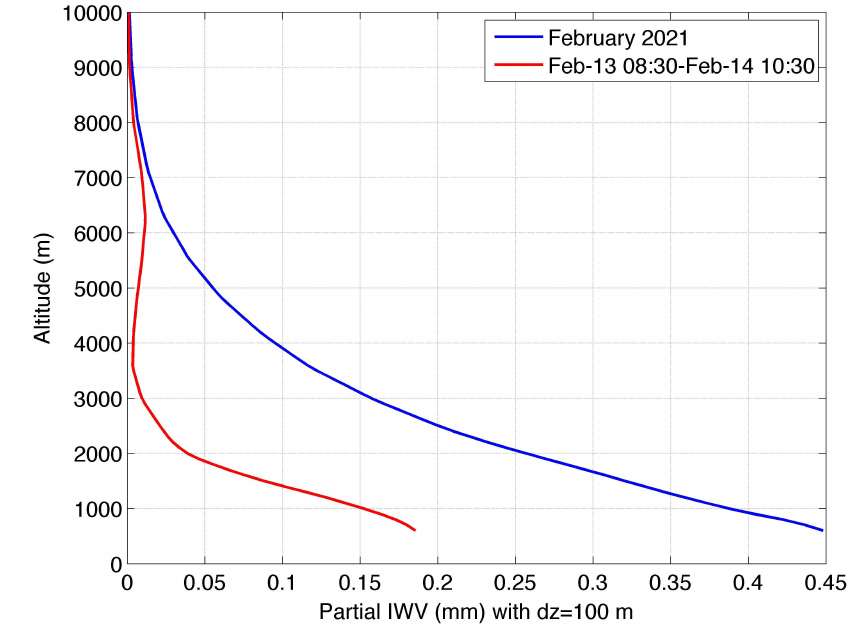
Figure 3. Partial IWV, which is partially integrated over altitude intervals of 100 m. The red profiles are for the short time period when the IWV depression occurred (for 13 February 2021, 8:30 UT–14 February 2021, 10:30 UT). The blue profile is for the average of the complete February